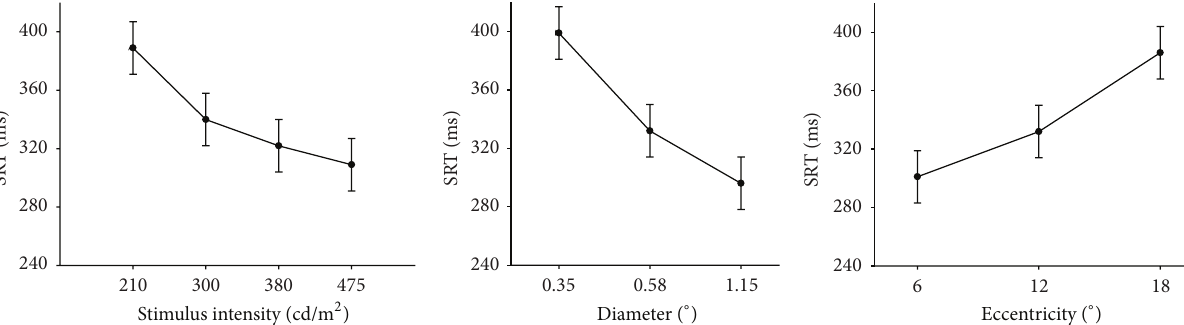
Figure 4: Estimated mean SRTs and their corresponding 95% confidence intervals for stimulus intensity, stimulus diameter, and stimulus eccentricity. (Other factors were fixed at 69 years, 91% signal quality and first session.) Pairwise contrasts showed statistically significant differences between all levels of each